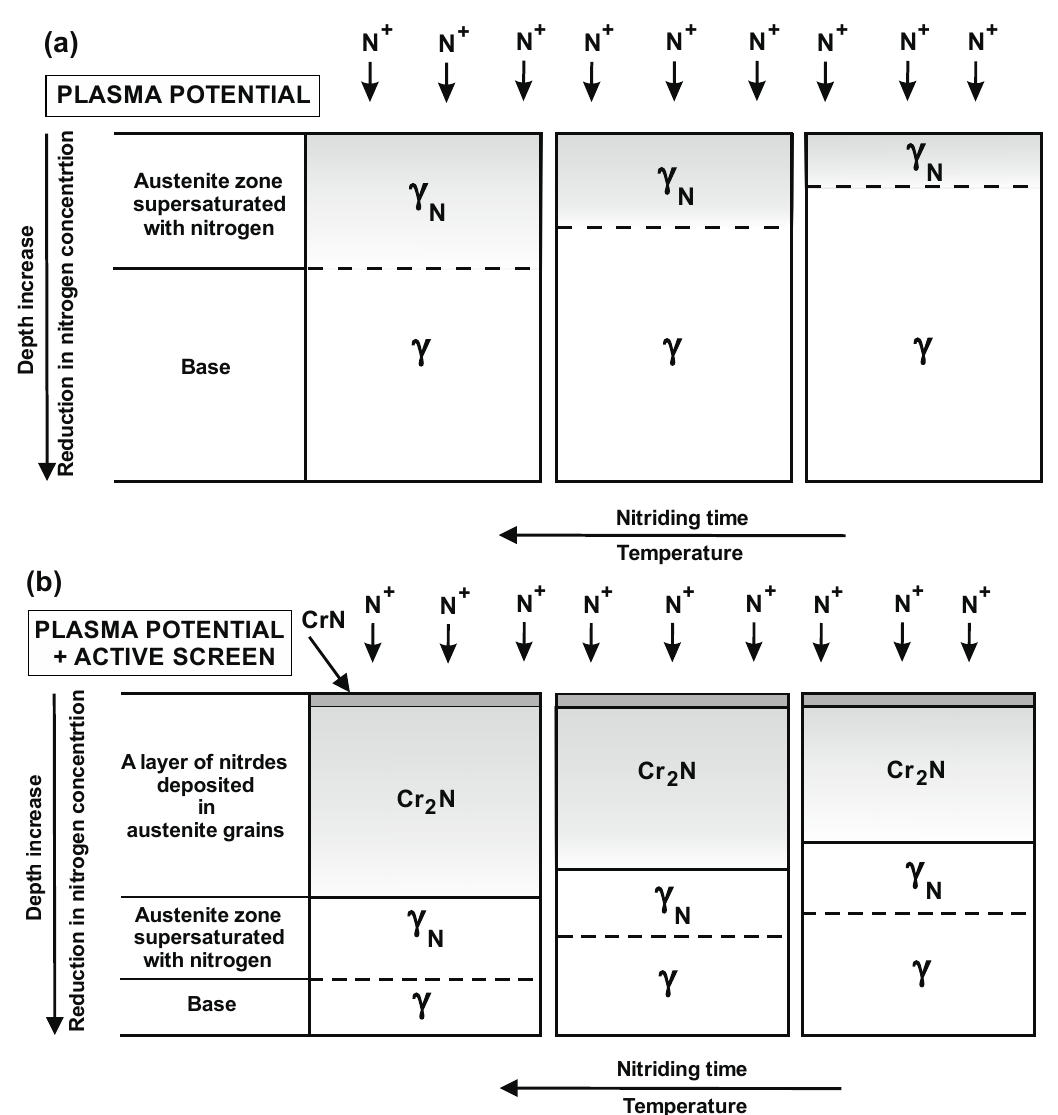
Figure 5. Models of the structure of surface layers on the 316L steel substrate depending on the location in the glow chamber: ( a ) plasma potential, ( b ) plasma potential + active screen.